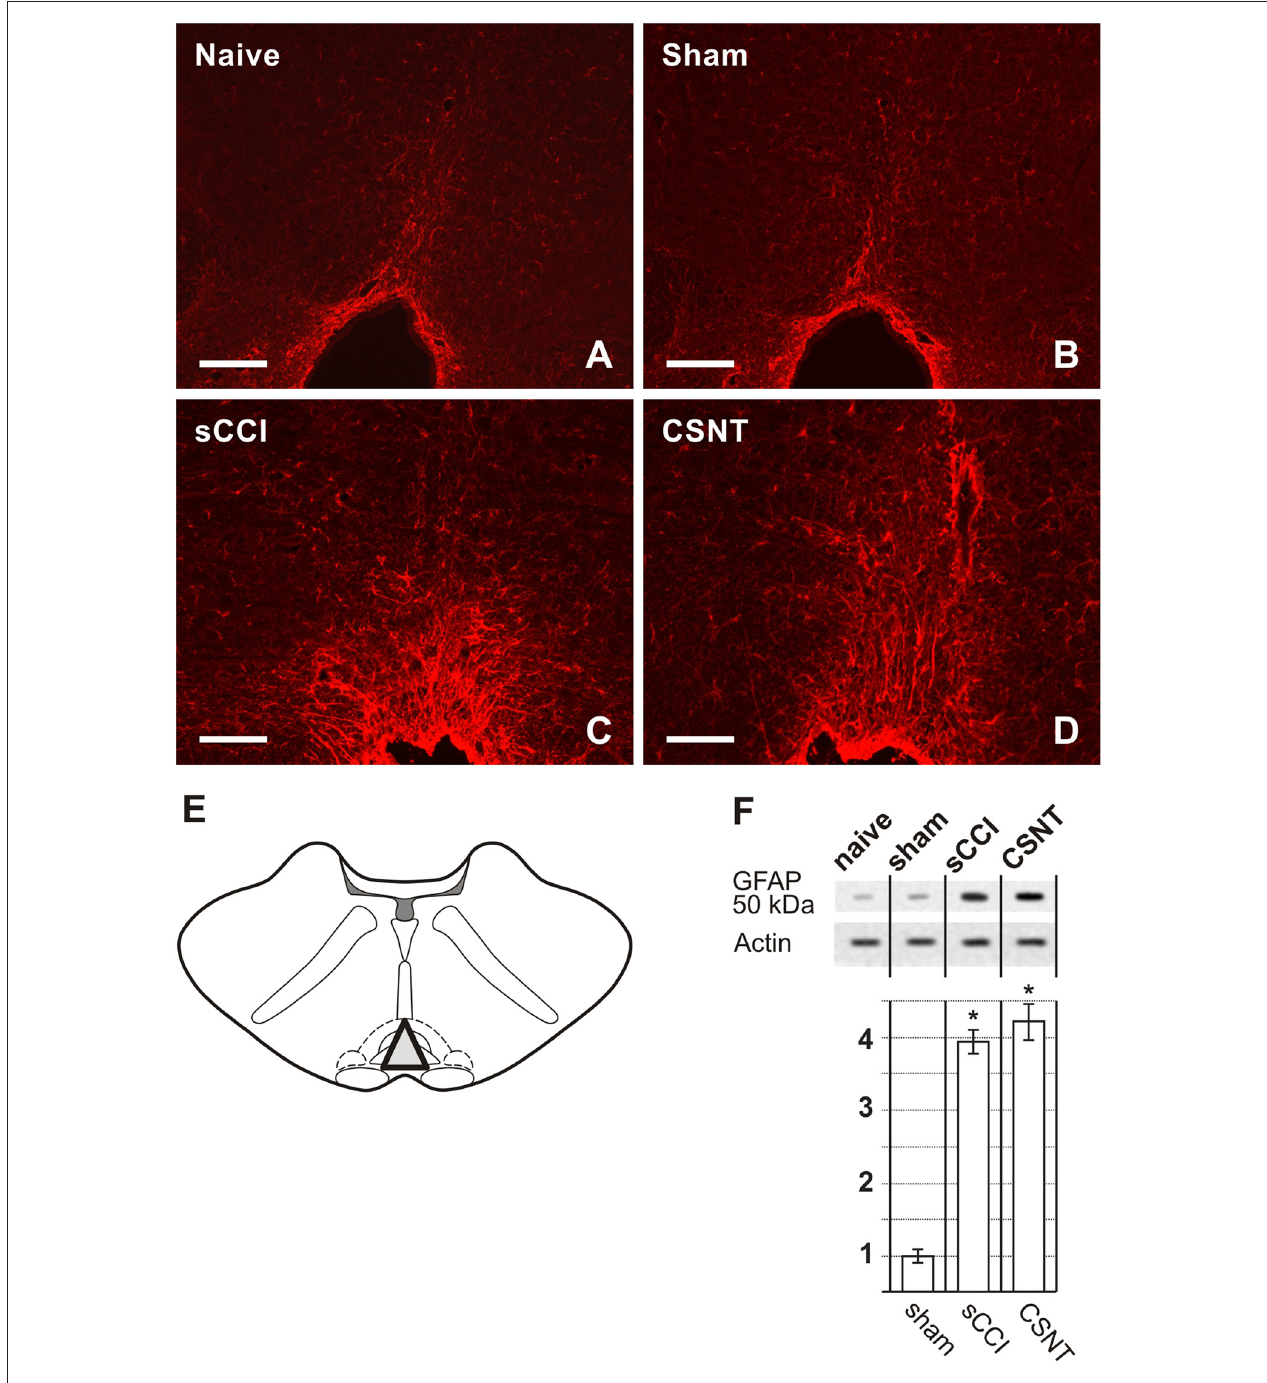
FIGURE 3 | Representative medullary sections showing rostral ventromedial medulla (RVM) from naïve and sham-operated controls (A,B) and 3 weeks after sCCI or CSNT (C,D) . The pictures illustrate increased intensity and expansion of GFAP immunostaining in RVM after sCCI and CSNT in comparison to RVM from naïve or sham-operated rat. Scale bars = 90 µ m. (E) The drawing illustrates dissection of RVM samples for western blots including the nucleus raphe magnus and gigantocellularis pars alpha (triangle). (F) The top panel illustrates representative western blot of GFAP protein in RVM of naïve and sham-operated rats and 3 weeks after sCCI or CSNT. ∗ Indicates a statistically significant difference ( p < 0.05) compared to the value from sham-operated rats.